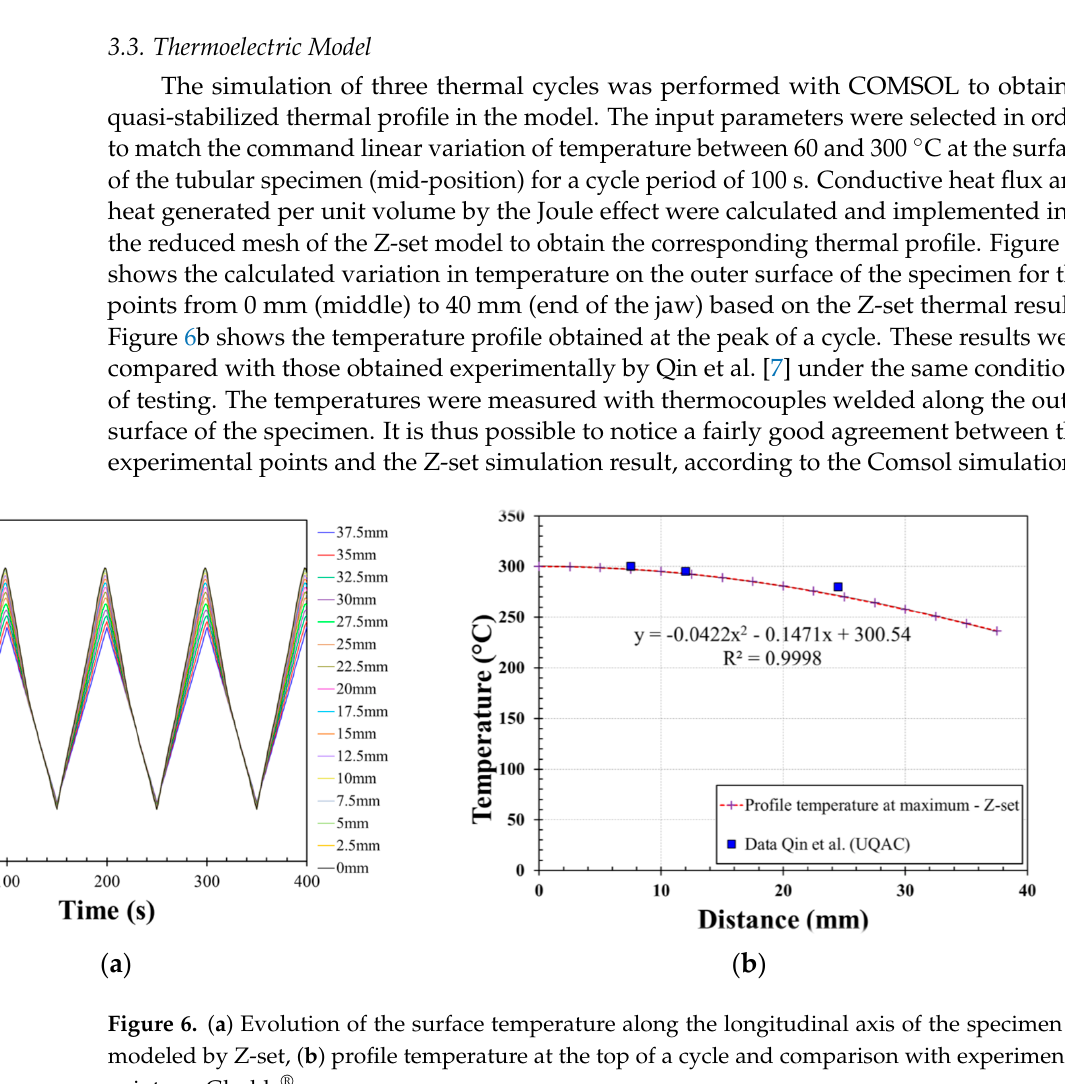
Table 4. Elastic and LM&C parameters used for modelling the mechanical behavior of